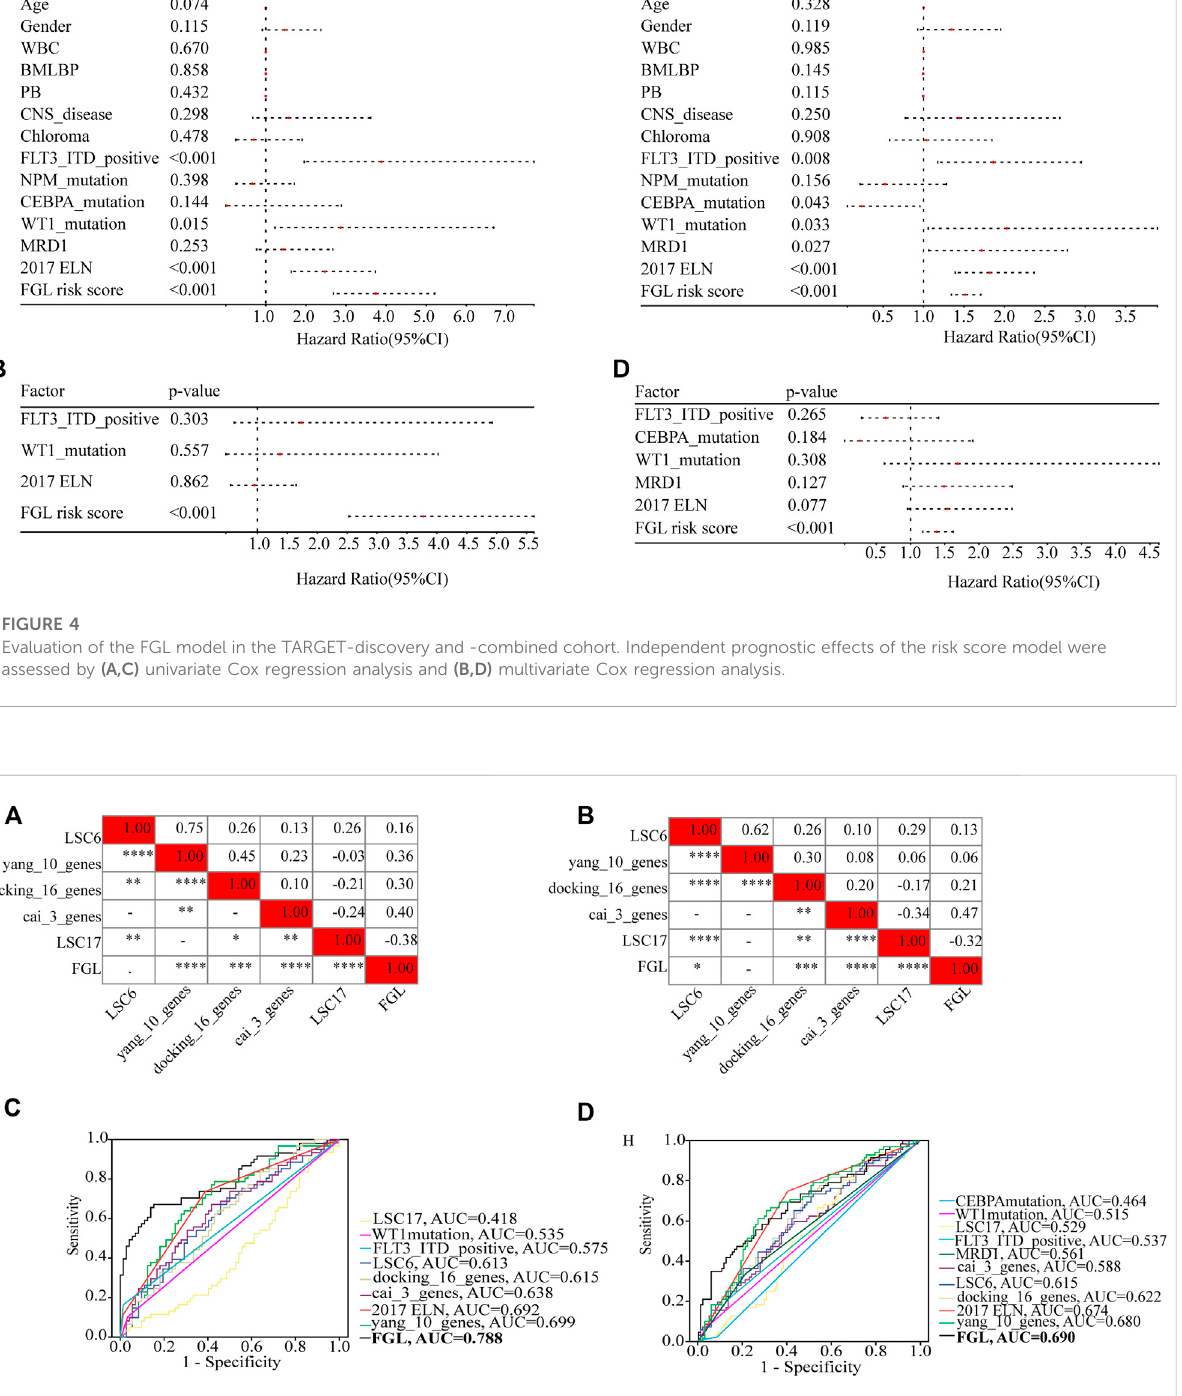
FIGURE 5 Heatmapshowingthecorrelations betweenFGLriskscoreandotherprognosticmodelsidenti fi edorvalidatedintheTARGETcohort (A,B) .FGL prognostic model had the best AUC value in TARGET-discovery cohort (C) and -combined cohort (D) .